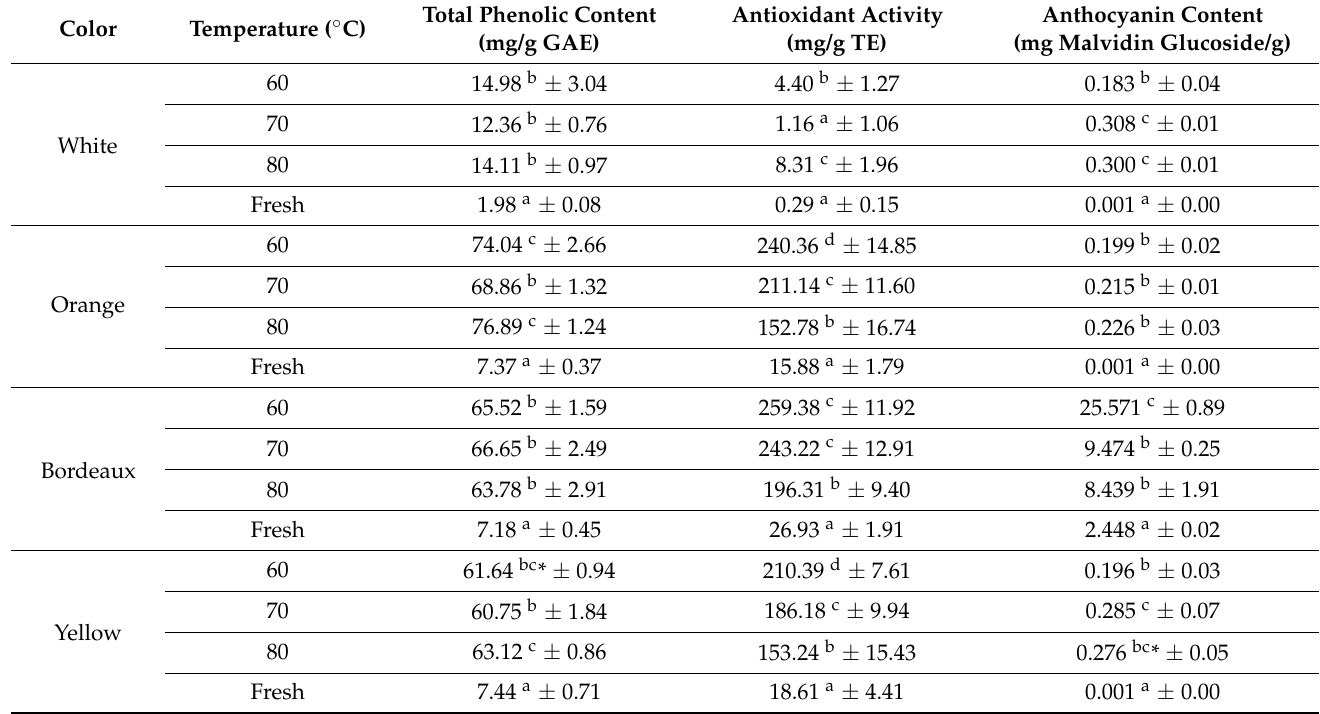
Table 2. Bioactive compounds of pansy flowers in fresh and dried